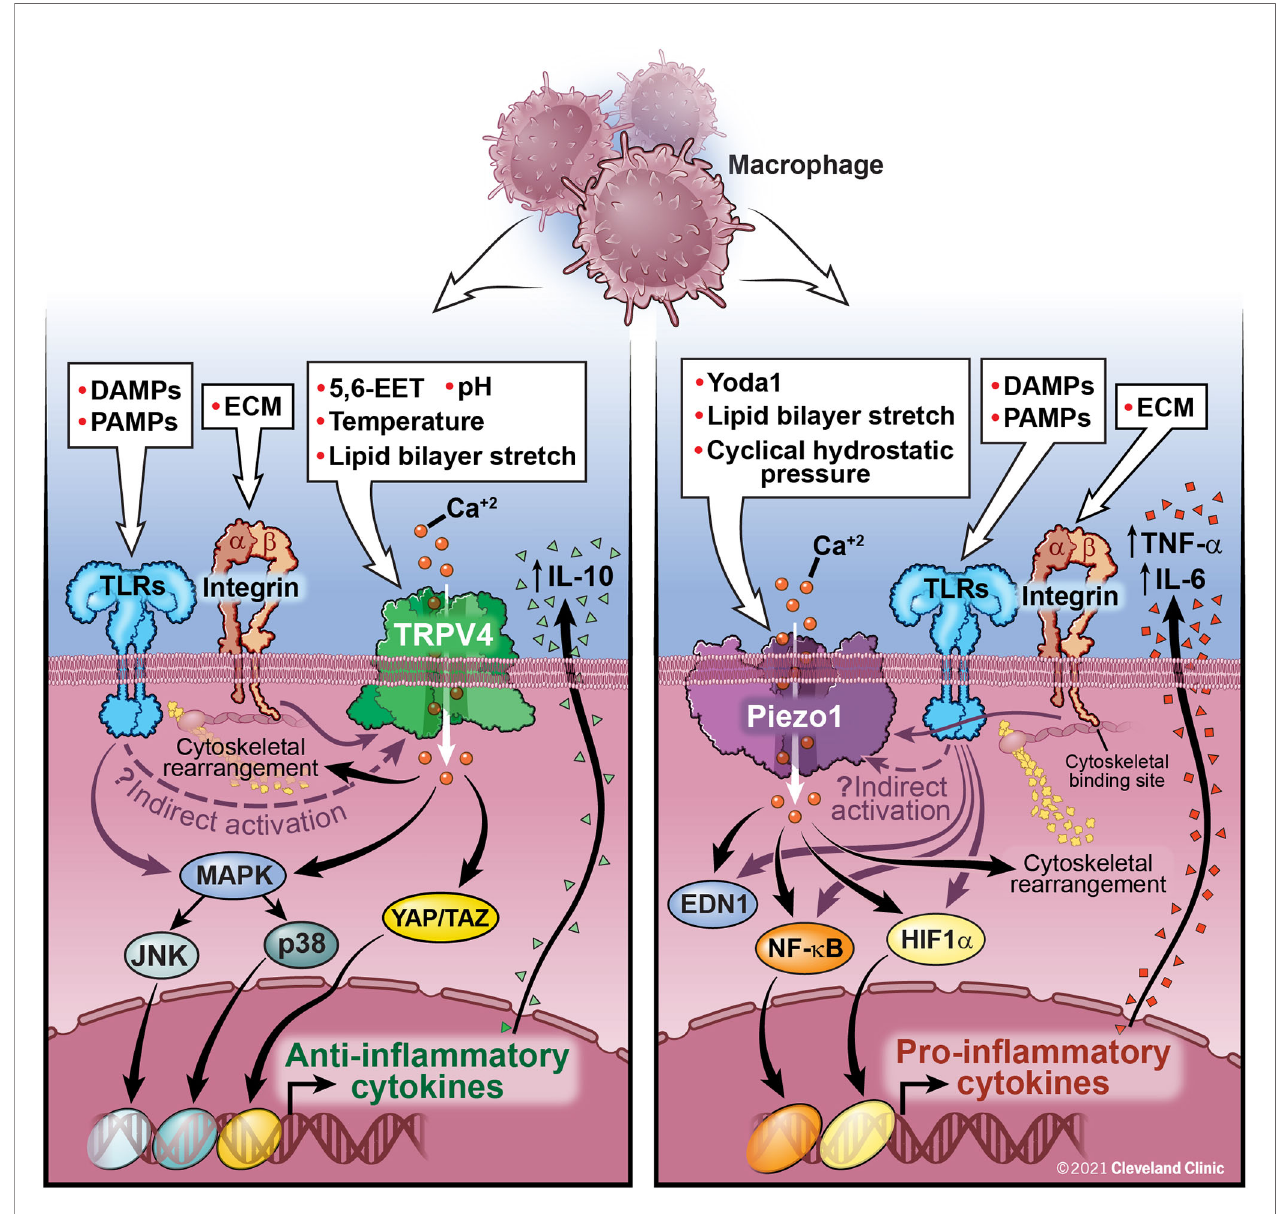
FIGURE 1 | Macrophage activation by TRPV4, Piezo1, and Integrins: TRPV4 is activated by both direct (chemical, mechanical) and indirect mechanisms (downstream signaling through interactions with integrins and TLRs, although the exact mechanism has yet to be elucidated). TRPV4 activation leads to Ca 2+ in fl ux and activation of several nuclear transcription factors, such as MAPK and YAP/TAZ leading to a decrease in pro-in fl ammatory cytokines and upregulation of anti-in fl ammatory cytokines, such as IL-10. Activation of Piezo1, either directly or through interaction with TLRs, leads to Ca 2+ in fl ux, AP-1 activation, production of EDN1, and nuclear translocation of HIF1 a and NF-kB leading to an increase in pro-in fl ammatory cytokines, IL-6 and TNF- a . Feedback loops between Piezo1 and actin polymerization also contribute to macrophage function. Integrins traverse the cell membrane with an extracellular ligand binding site connecting to an intracellular cytoskeletal bind site. Integrins are important for control of viral and bacterial infections through interactions with TLRs. Further study is needed to fully understand the interactive functions of Piezo1 and TRPV4 and their ability to be activated by integrins and TLRs. These interactions are likely cell-type and context speci fi